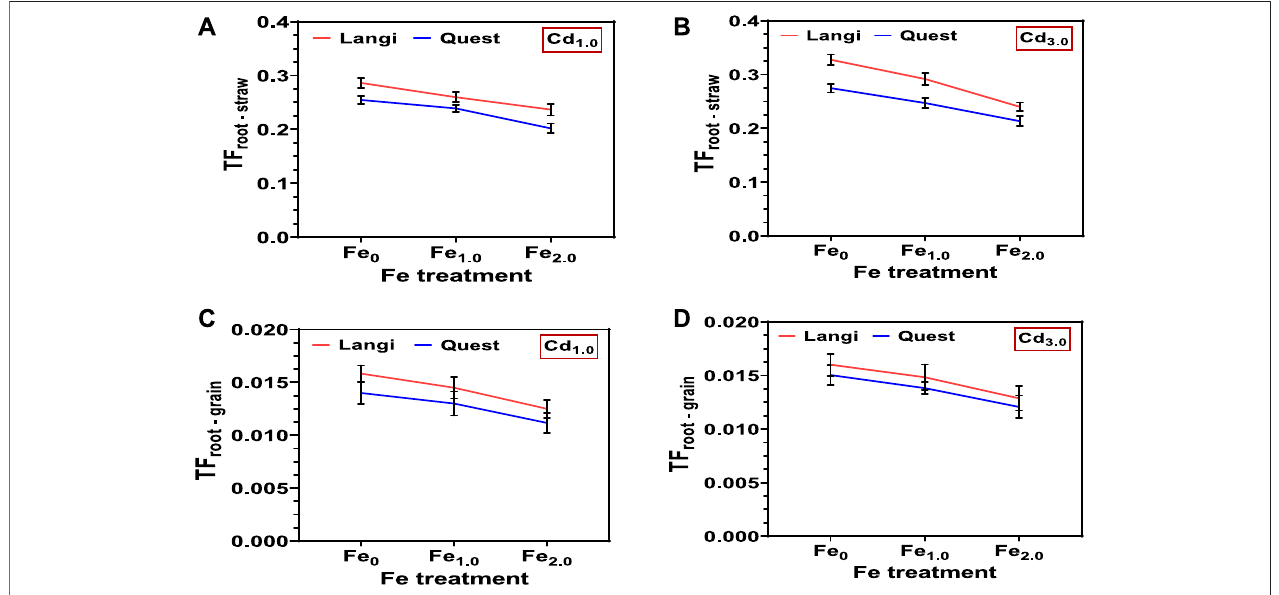
FIGURE 4 | Effect of Fe on translocation factors of Cd from root to straw (A,B) and root to grain (C,D) between two Cd levels.